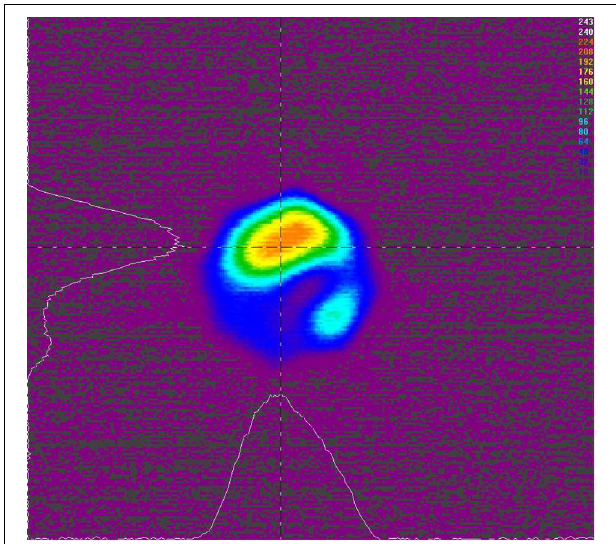
FIGURE 8 | False color image of spatial beam profile delivered by NCF at 515nm (6 ps pulse) [53].